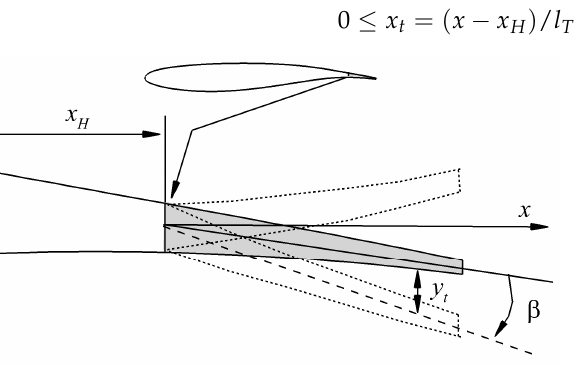
Figure 1. The definition of trailing-edge flap relative to the OAT15A airfoil.